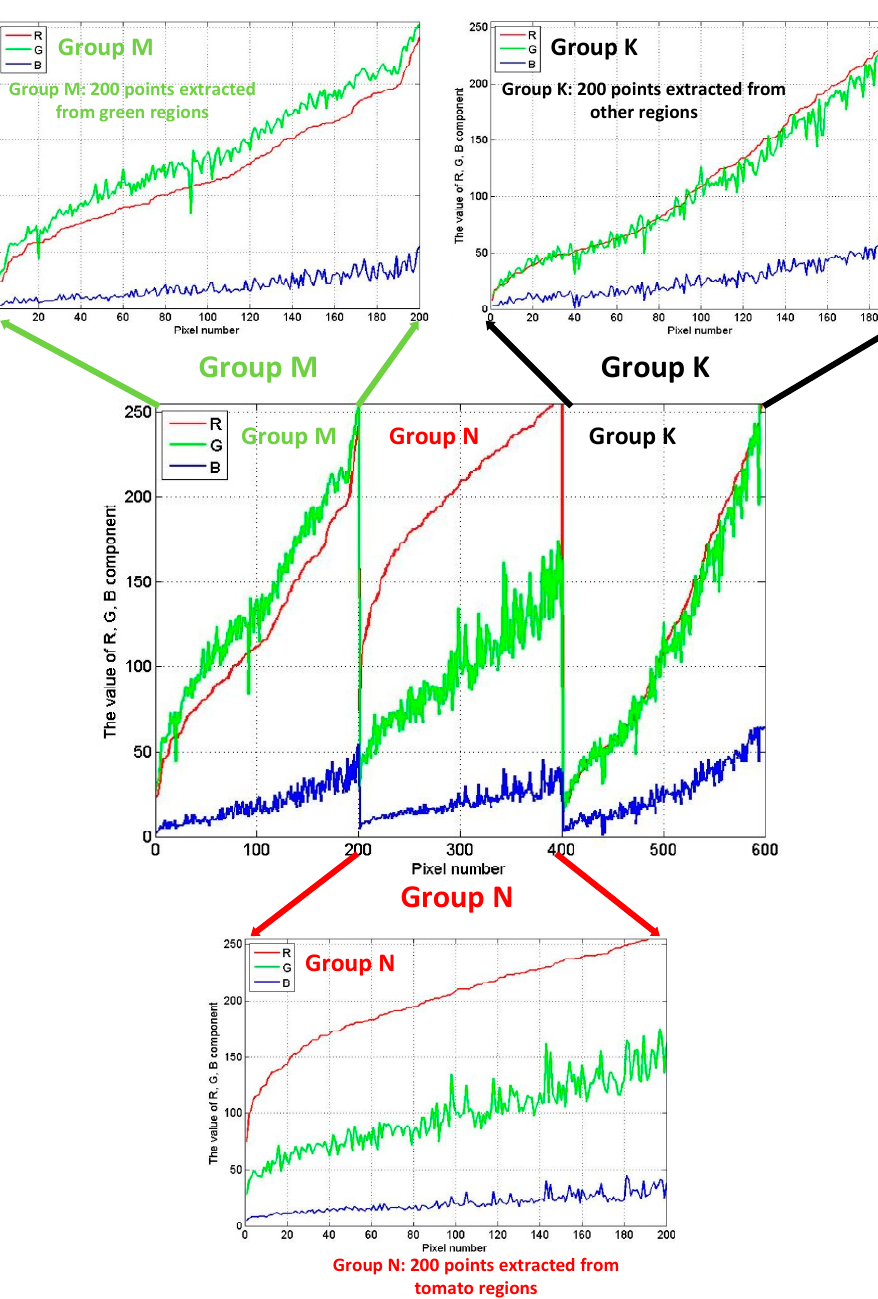
Figure 4. The R, G, B components of three groups M, N and K after reducing B’s proportion.